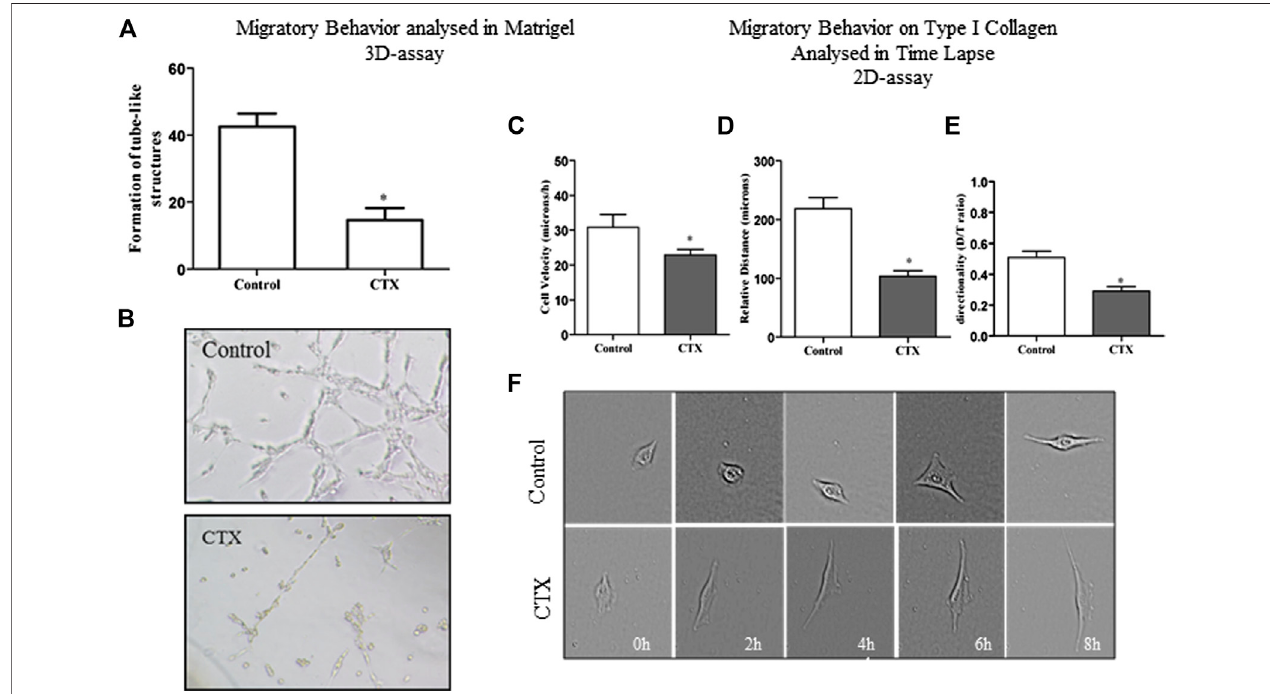
FIGURE3| EffectofCTXontheformationoftubule-likestructuresin3D-matrigelandmigratorybehaviorontype2D-typeIcollagenevaluatedinTimeLapse.CTX- pretreated t.End.1 cells were added on polymerized Matrigel in 96-well plates and incubated for 6 h. The results are expressed in a number of tubular structures and represent the count of fi ve fi elds from triplicates of each group. The data are presented from three distinct experiments. * p < 0.0001, compared to the control group (A) . Photomicrograph of representative tube formation. Images obtained at the × 40 objective (B) . For the 2D-assay, time lapse images obtained from CTX pretreated t.End.1 cells migrating under collagen coating in In Cell Analyzer GE 2200 equipment in a × 10 objective for 18 h. The t.End.1 cell velocity (C) , relative distance (D) , and directionality (E) weremeasured.TheseparameterswereevaluatedusingImageJsoftware.Dataaremean ± s.e.m.* p < 0.05bycomparison withthecontrolgroup( n (cid:2) 29) and CTX ( n (cid:2) 33). The graphs were plotted from the data collected during three independent